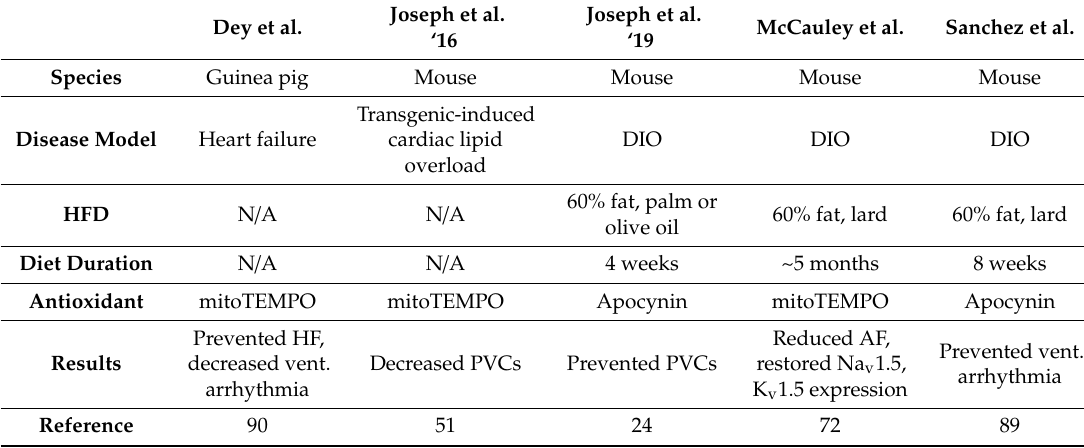
Table 1. Antioxidants preventing arrhythmia in